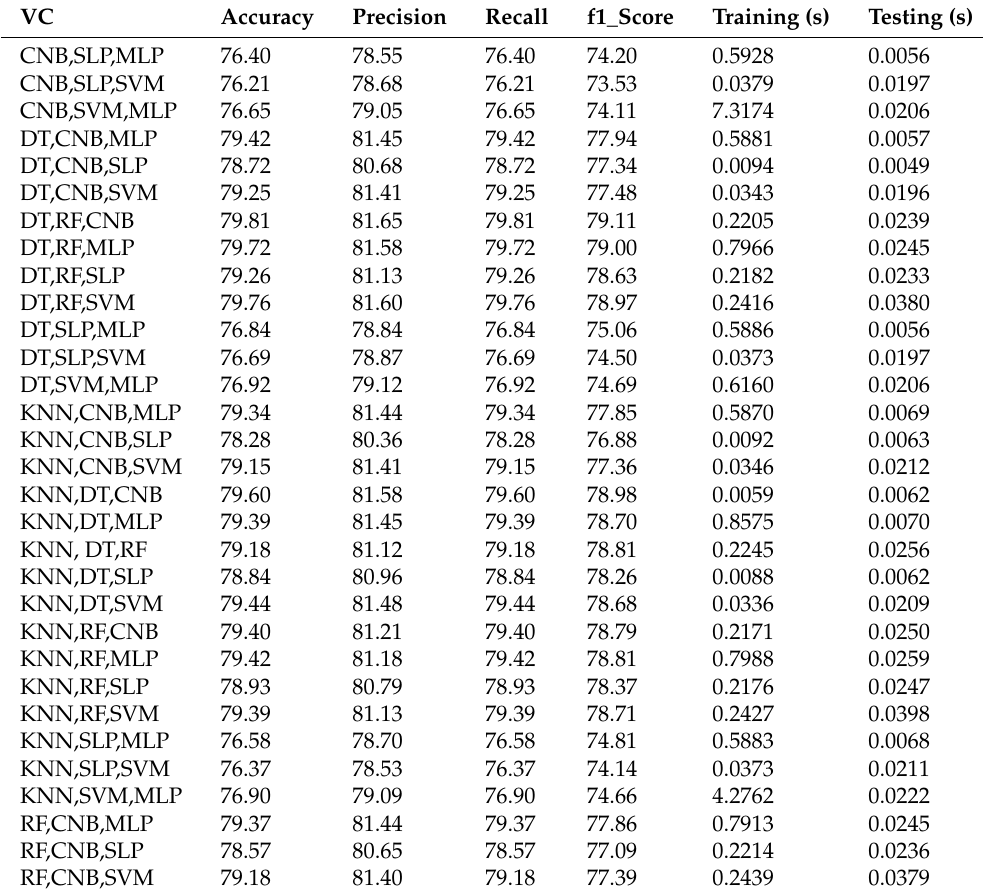
Table 5. Ensemble Learning Algorithms (combinations of three algorithms).